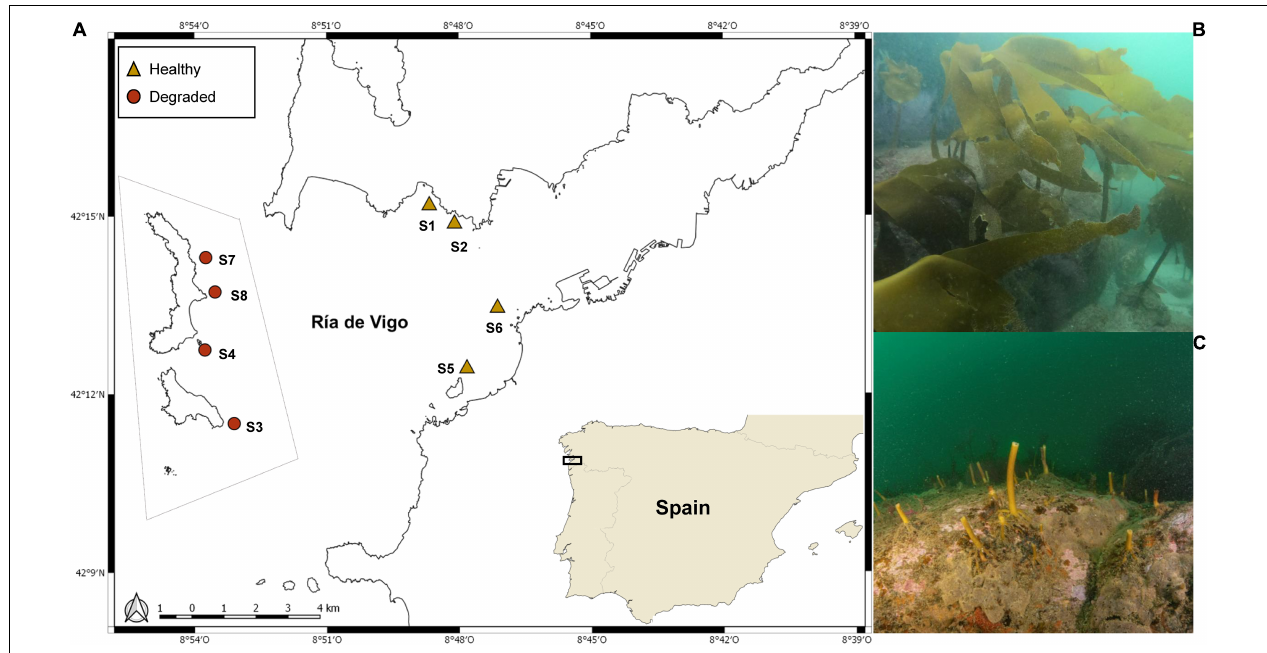
FIGURE 1 | Laminaria ochroleuca . (A) Map showing the location of the eight kelp reefs selected in the study. Symbols indicate healthy (triangles) and degraded (circles) golden kelp reefs in Ría de Vigo, NW Spain. The dashed gray line shows the limits of Islas Atlánticas National Park (MPA). Underwater photograph from kelp reefs in winter showing: (B) well-developed kelp reef and (C) overgrazed kelp reef. Photograph credits: Manuel E.